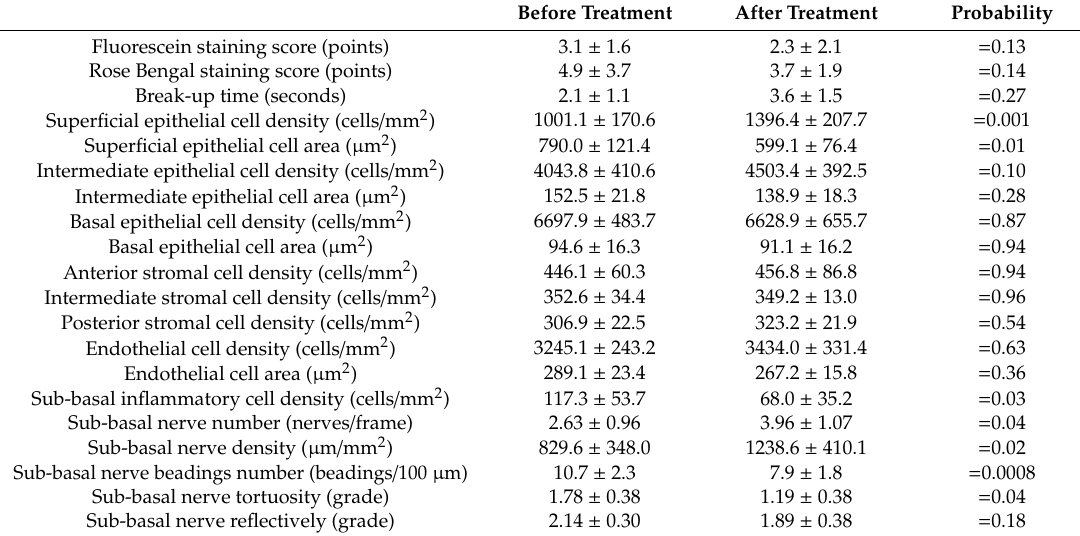
Table 2. Changes of tear functions, ocular surface vital staining scores, and in vivo laser-scanning confocal microscopic data in patients with Sjögren’s syndrome by the treatment